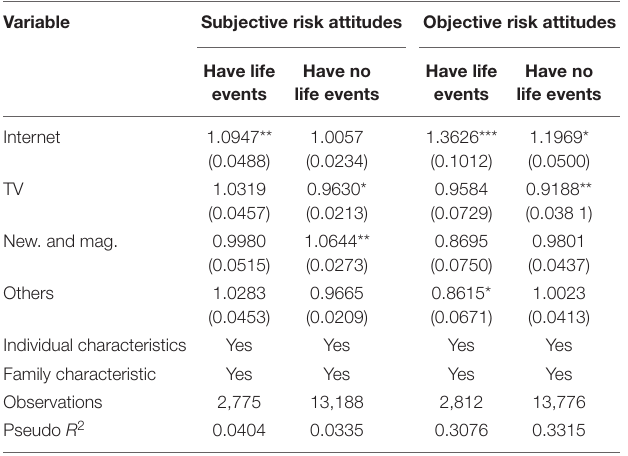
TABLE 11 | Heterogeneity of life